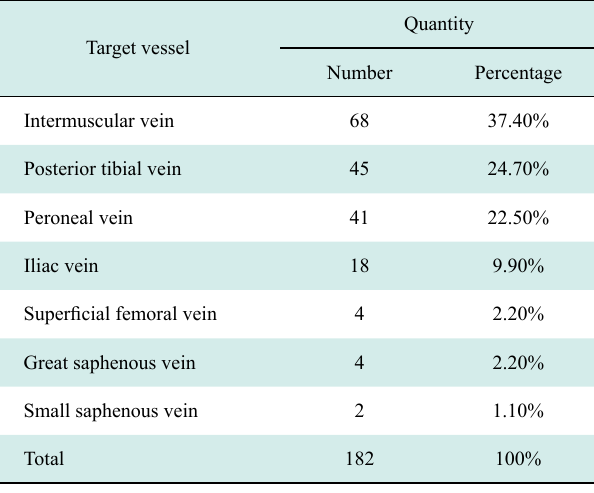
Table 4 Bedside ultrasound examination positive findings of bilateral lower limb vessels of COVID-19 confirmed patients